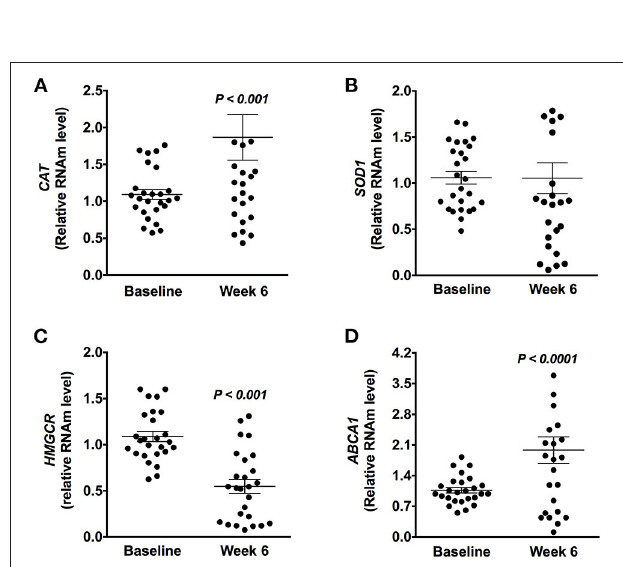
FIGURE 5 | Differential expression in peripheral blood mononuclear cell of genes involved in antioxidant activity and cholesterol flux modulated by Chaya intake. (A) Relative gene expression of CAT (catalase). (B) Relative gene expression of SOD (Superoxide dismutase 1). (C) Relative gene expression of HMGCR (hydroxy-methyl-glutaryl coenzyme A reductase). (D) Relative gene expression of ABCA1 (ATP-binding cassette transporter A1). Data are expressed as the mean ± SD. Statistical analysis was performed using a paired t -test after logarithmic